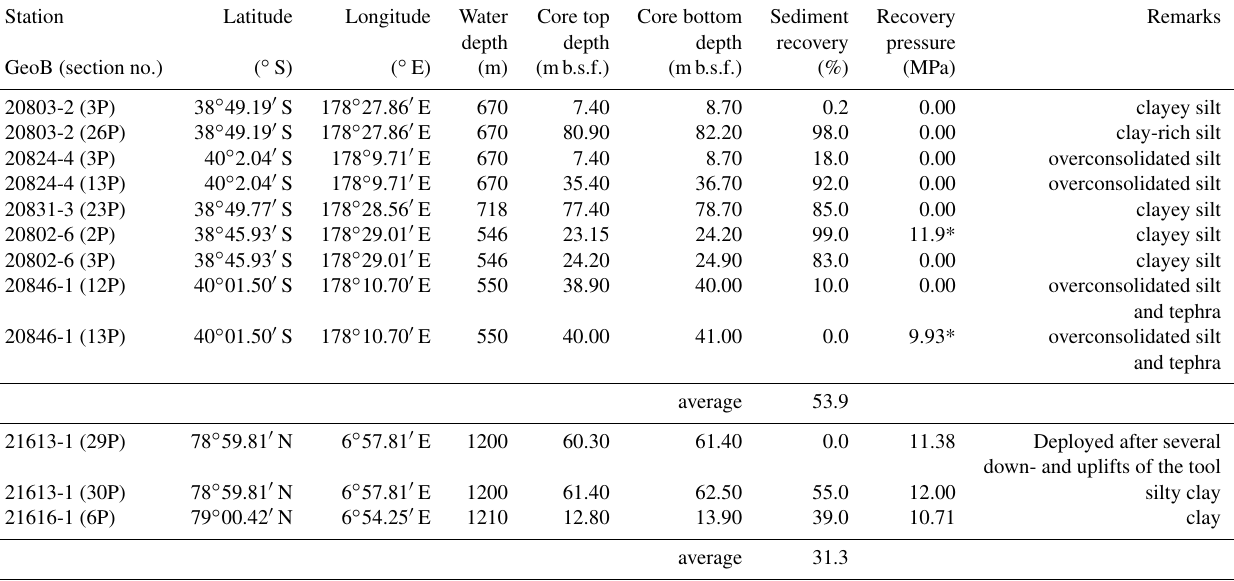
Table A1. Overview of sections cored with MDP during SO247 (MeBo200) and MSM57/1 (MeBo70) (in chronological order). Further information on cores collected during the cruises are provided in the cruise reports (Huhn, 2016; Bohrmann et al., 2017). Station GeoB (section